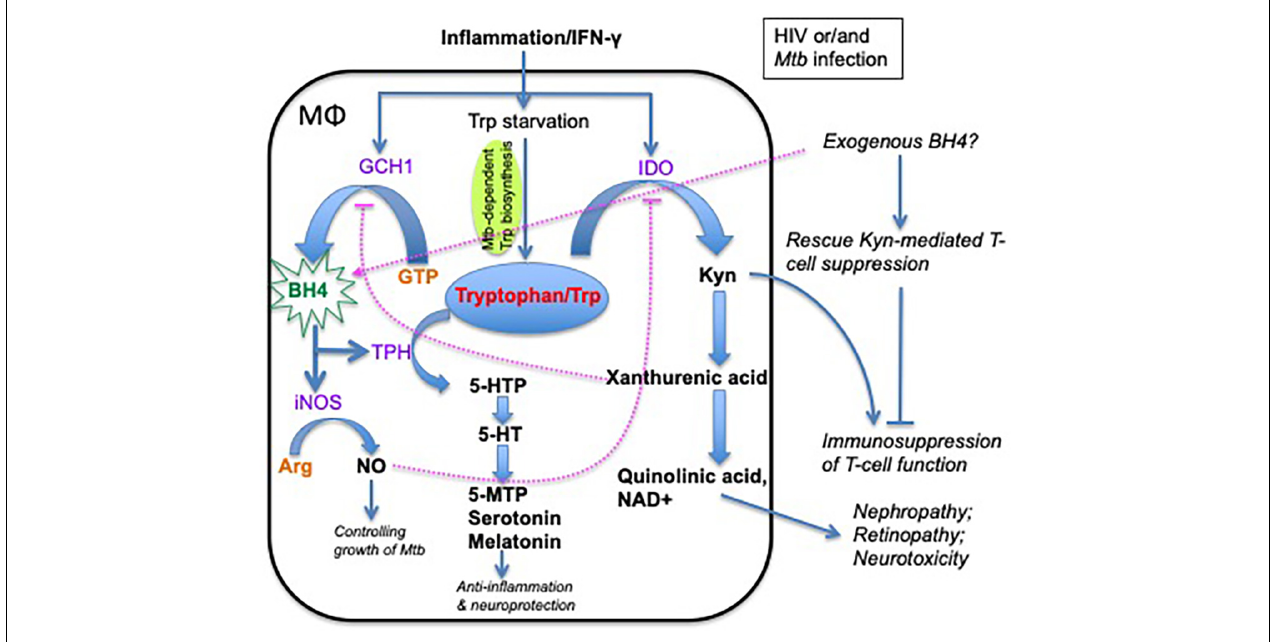
FIGURE 2 | Schematic of alternate tryptophan pathways and metabolites and their effects on macrophages, inflammation, and neurofunction. Tryptophan has two major metabolic pathways: (1) indoleamine 2,3-dioxygenase (IDO) pathway, which generates kynurenine-associated immunosuppression, and (2) tryptophan hydroxylase (TPH) pathway in which the tryptophan metabolites are involved in neural function modulation and anti-inflammatory effects. Note that tryptophan metabolism plays an important role in host immunity and neurological disorders in HIV/ Mtb infection. BH4 is an essential enzyme cofactor for NOS in NO production, and THP in the conversion of tryptophan to 5-HTP. Importantly, NO strongly inhibits IDO1 activity, and exogenous BH4 may rescue kynurenine-mediated T-cell suppression. GCH1, GTP cyclohydrolase 1; BH4, tetrahydrobiopterin (one of tryptophan hydroxylase); 5-HTP, 5-hydroxytryptophan; 5-MTP, 5-methoxytryptophan; 5-HT, 5-hydroxytryptamine (serotonin); melatonin, N -acetyl-5-hydroxytryptamine; TPH, tryptophan hydroxylase; IDO, indoleamine 2,3-dioxygenase; Kyn, kynurenine; NO, nitric oxide; iNOS, inducible nitric oxide synthase; NAD, nicotinamide adenine dinucleotide; D1MT, 1-methyl- D